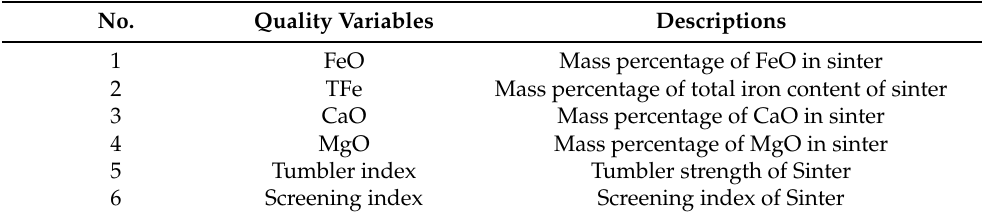
Table 1. Table of some sinter quality variables.